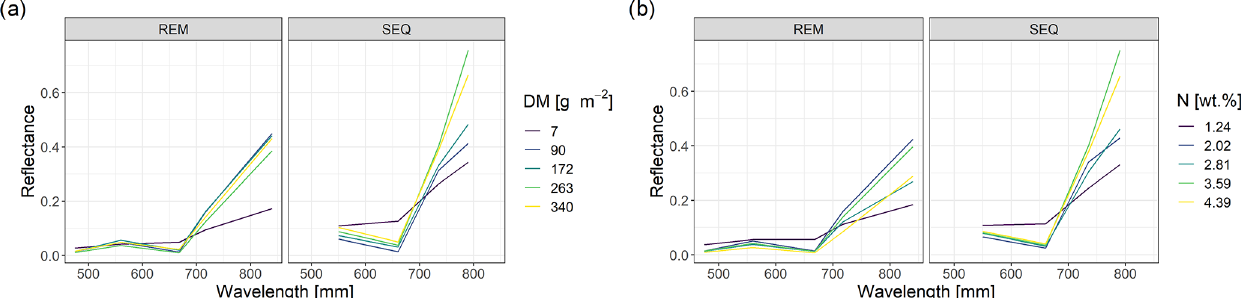
Figure 4. Spectral profiles of subplots with different levels of DM (a) and N concentration values (b) . Shown are the profiles of the subplot samples with min and max values as well as the ones that have DM or N concentration values that approximately correspond to the 25th, 50th, and 75th